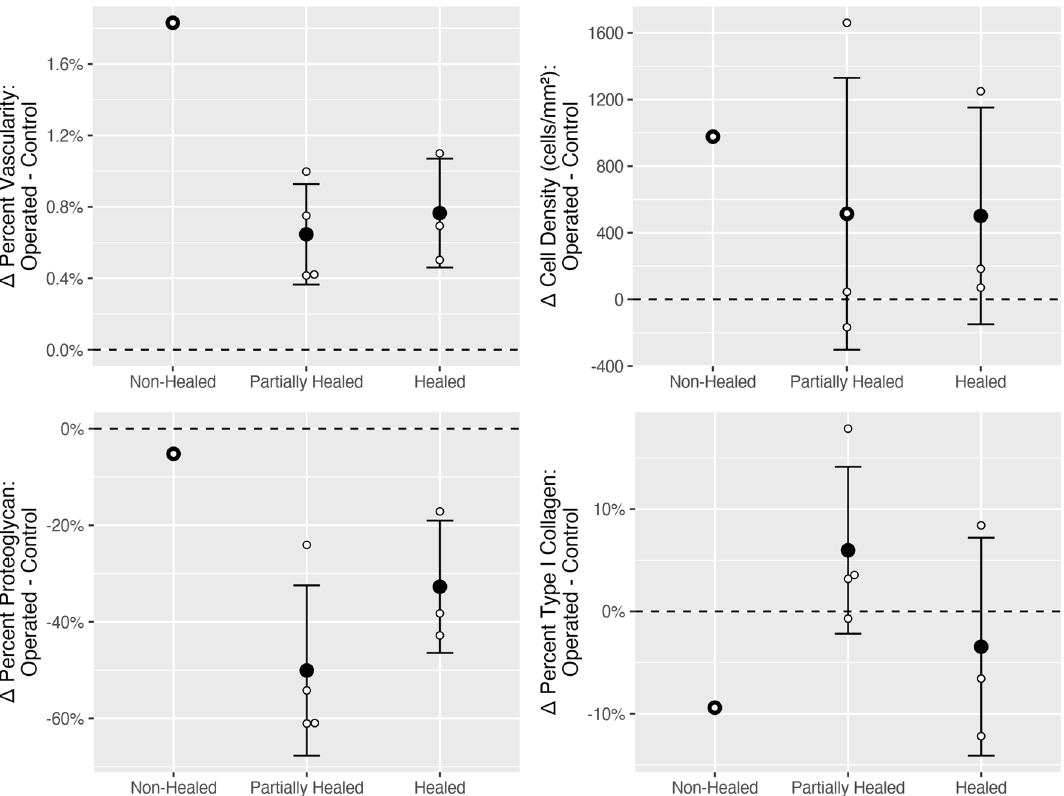
Figure 5. Average difference in morphological parameters between induced lesions (sutured/non-sutured) and contralateral control meniscal sections. Vascularity, cell density, proteoglycan content (safranin-O), and type I collagen were binned according to the healing status (non-healed, partially healed, and healed tears). The average difference between non-healed (n = 1), partially healed (n = 4), and healed (n = 3) tears and their respective contralateral control are shown with standard deviation bars. Cell density was the difference in cells per mm 2 . All other parameters are differences in percent stain/immunostain positivity. Non-healed tear does not have error bars as there was only one tear with this status. Note the dotted black line indicating no difference between induced lesions and their contralateral